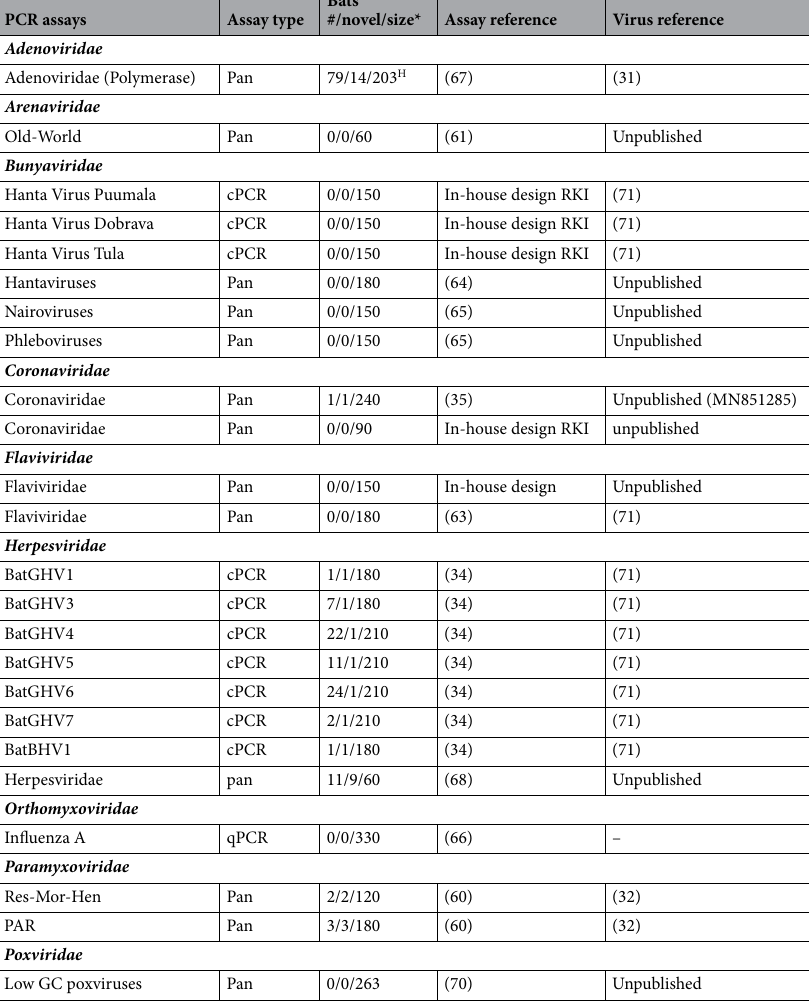
Table 2. Results PCR screening. Bats were screened for the presence of virus nucleic acids by different PCR assays. pan generic family-specific assay, qPCR quantitative real-time PCR, cPCR conventional specific PCR. *#/novel/size: #, number of positive samples; novel, number of novel viruses obtained; size, bat sample size. H Screened in collaboration with our Hungarian colleagues (see Ref. 33